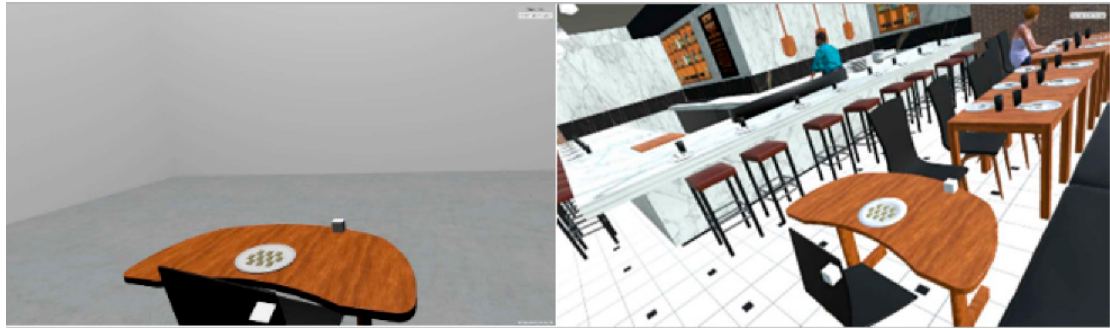
Figure 1. ( left ) The minimal blank VR scene and ( right ) the restaurant VR scene.